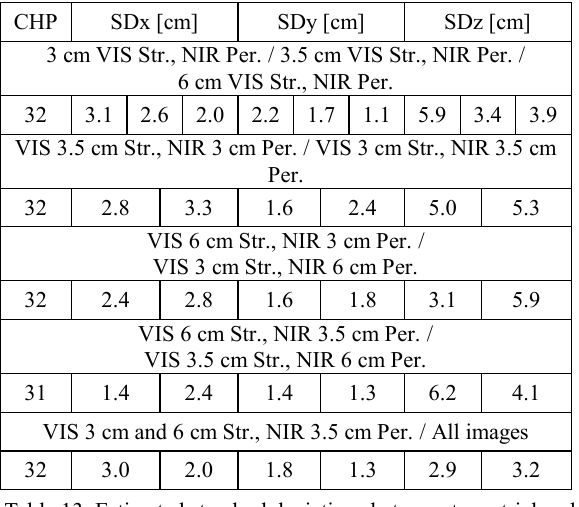
Table 10. Estimated standard deviations of coordinates for